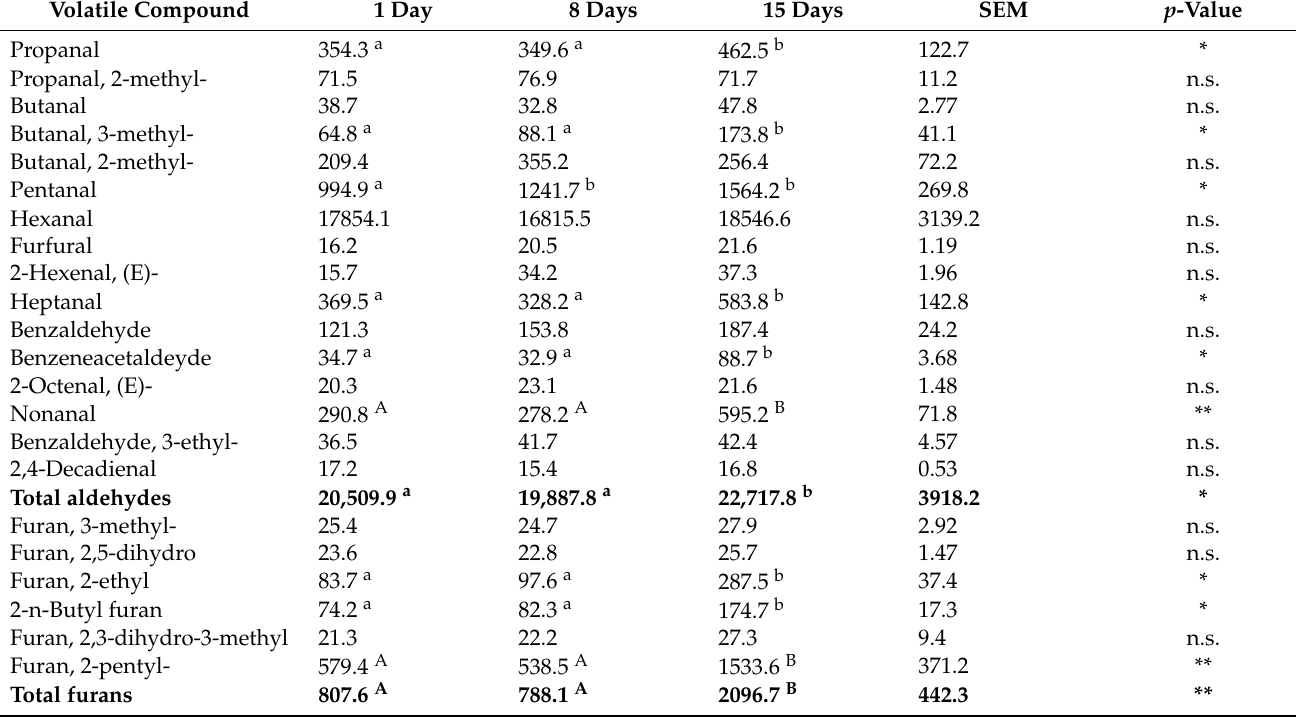
Table 3. Effects of ageing period on donkey meat aldehyde and furan content (AU × 10 3